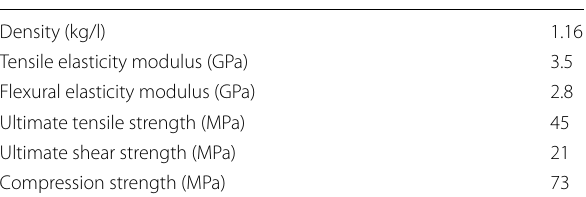
Table 5 Resin properties.